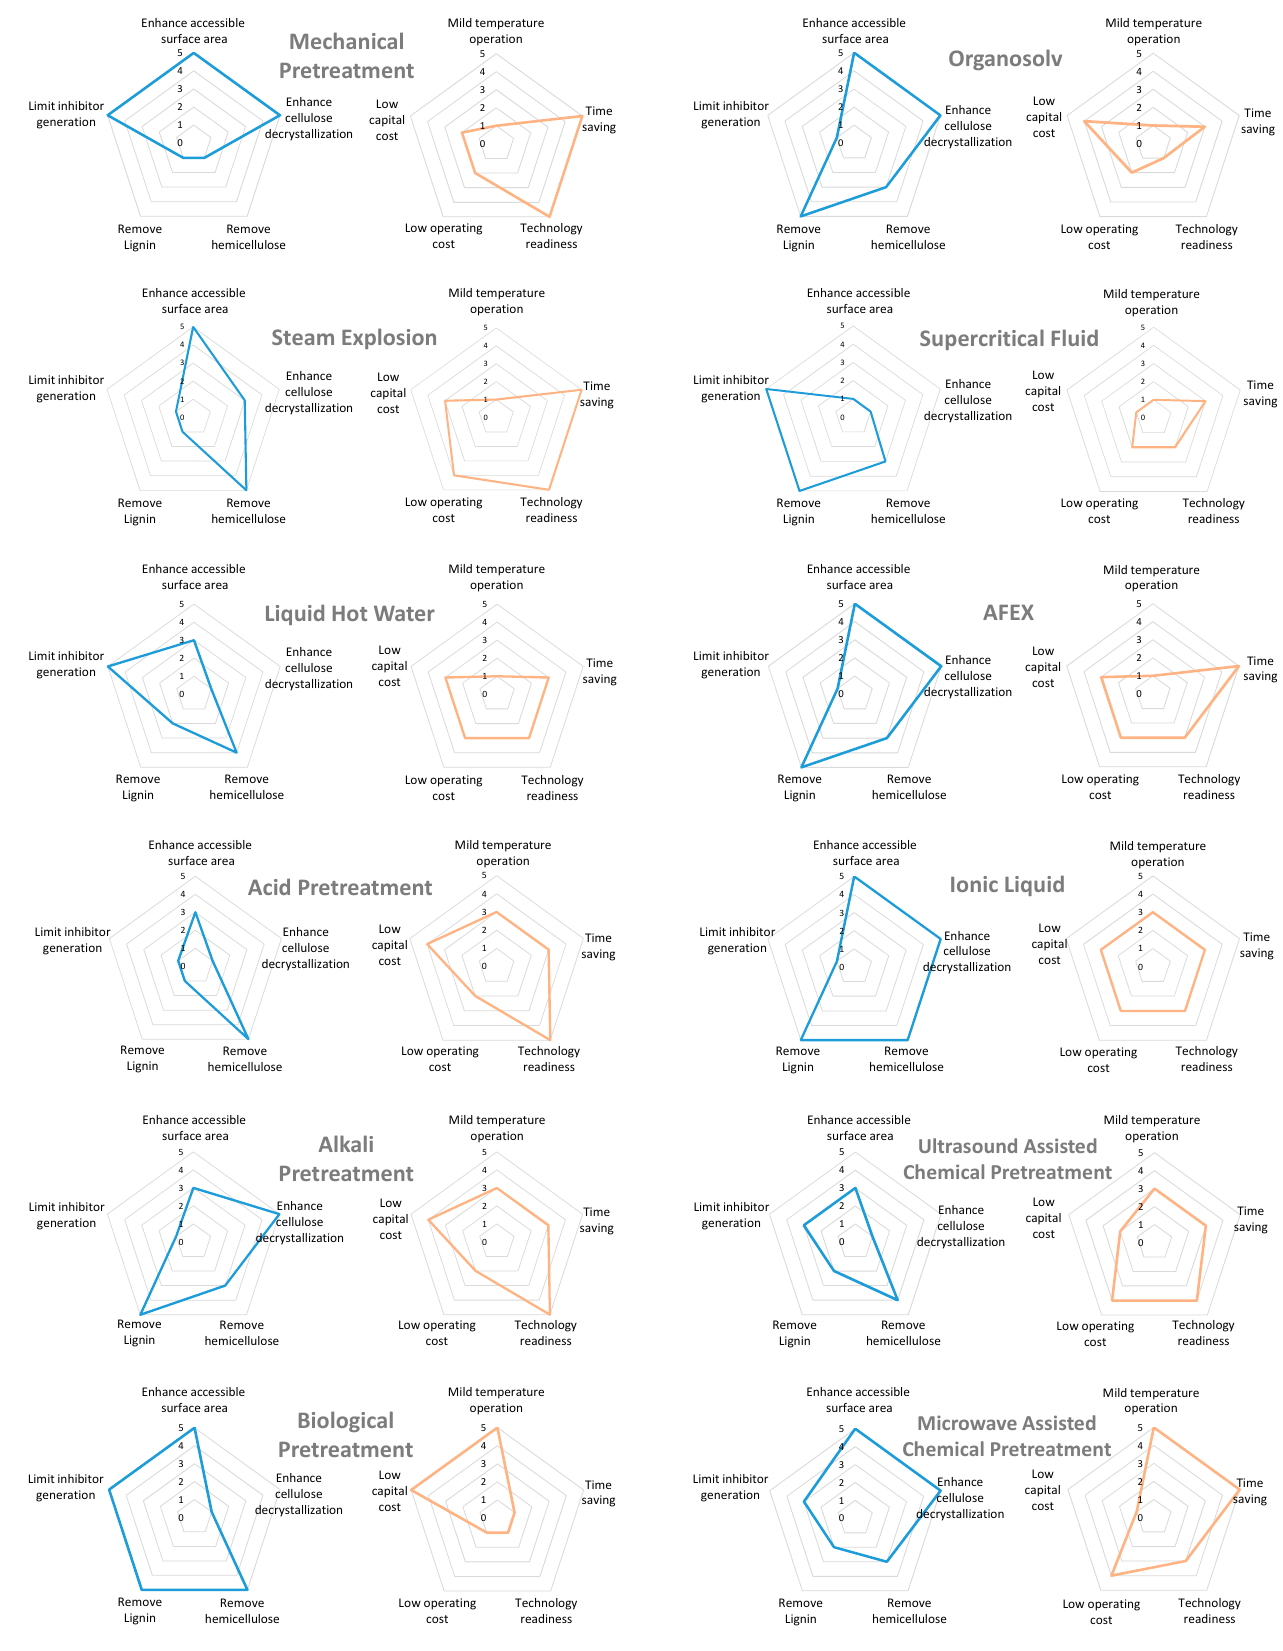
Figure 1. Radar chart of the characteristic effect on biomass (blue) and additional benefits (orange) of pretreatment method.